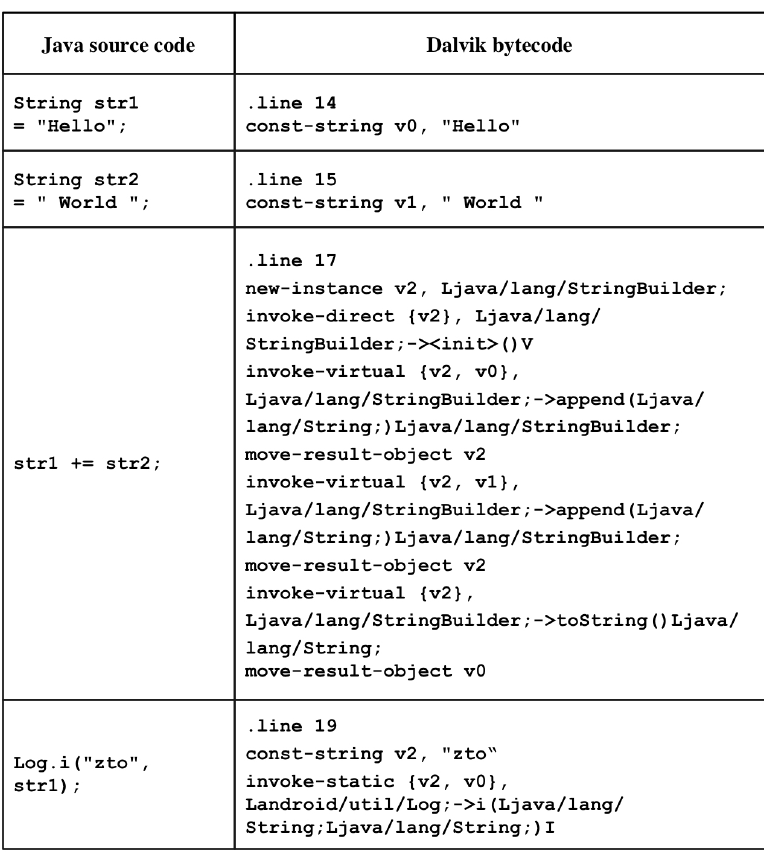
Figure 8. Original Java source code vs. Dalvik bytecode.